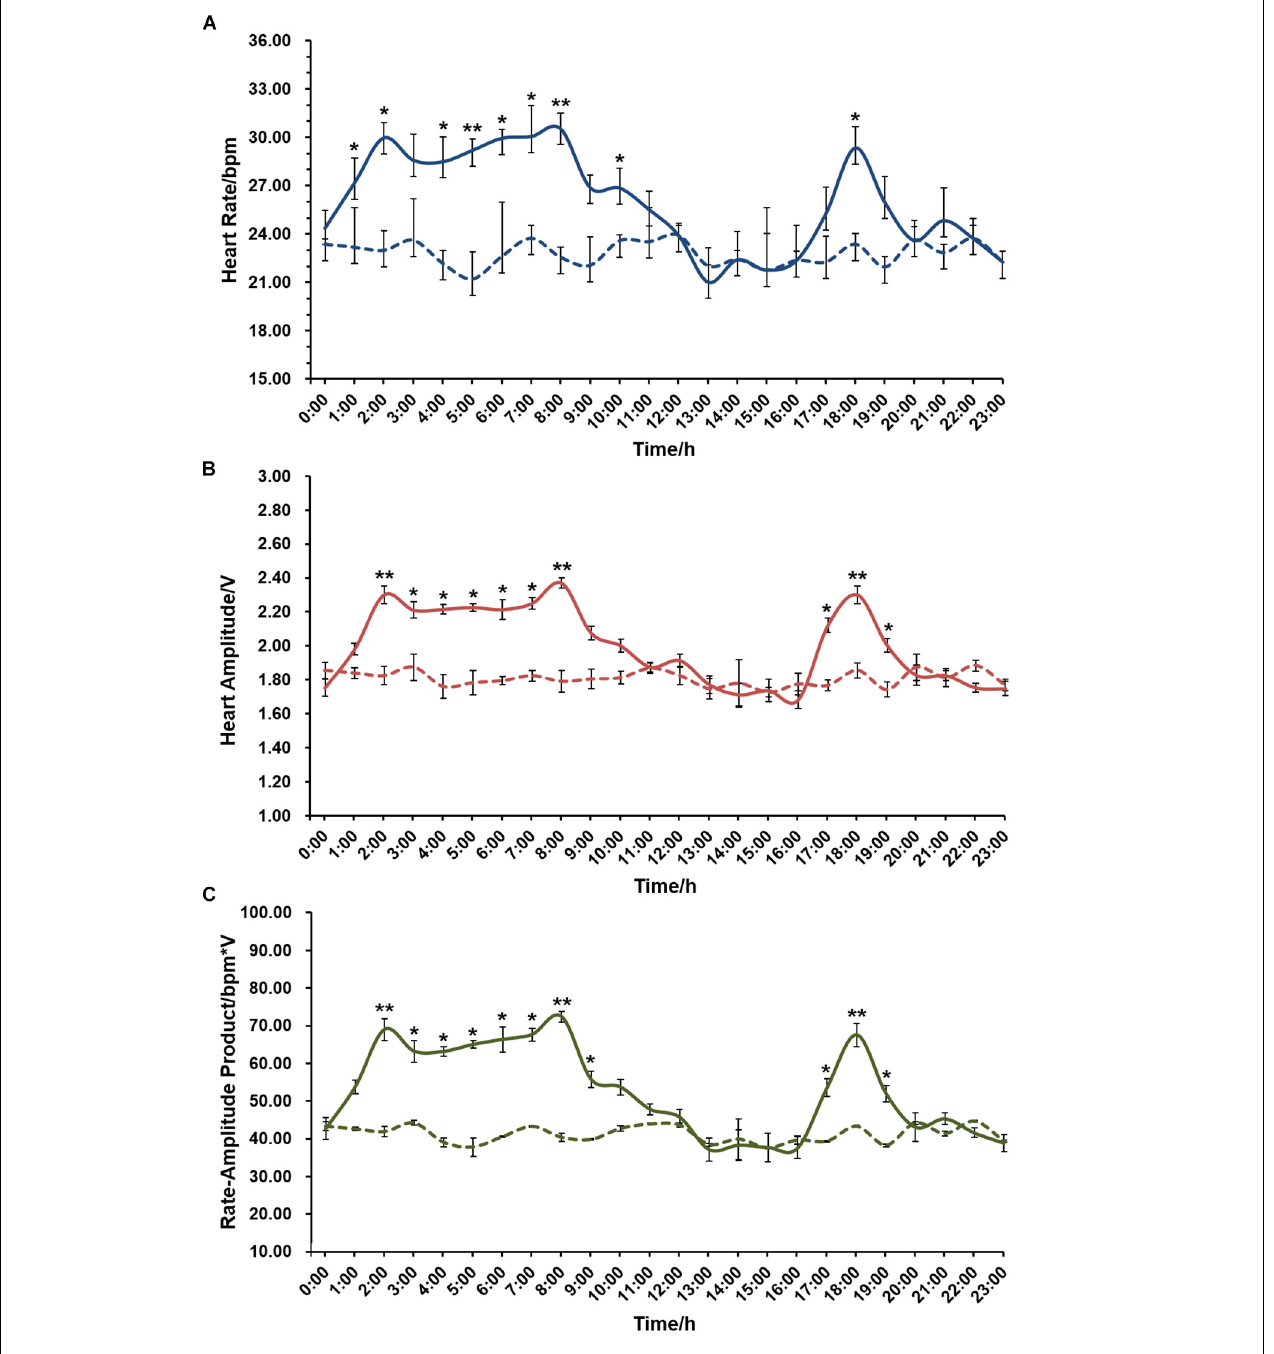
FIGURE 5 | The effect of circadian rhythm on cardiac activity of scallop ( N = 24 for each group). (A) The effect of circadian rhythm on HR. (B) The effect of circadian rhythm on HA. (C) The effect of circadian rhythm on RAP. The x -axis represents a 24 h-period from midnight (0:00) to 11 pm (23:00). The solid and dotted curves indicate HR/HA/RAP monitored under natural light (a light:dark period of 12 h:12 h) and in a darkroom, respectively. ∗ Indicates P < 0.05; ∗∗ indicates P <